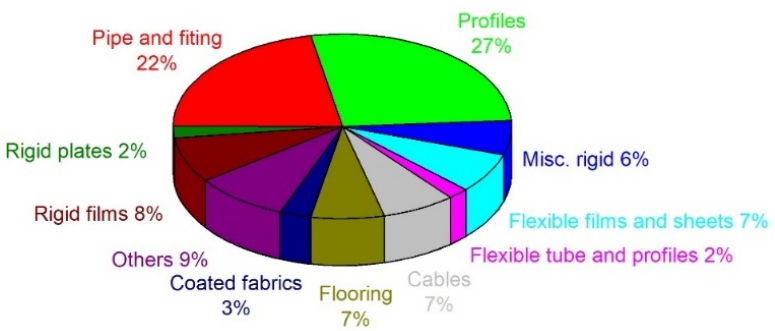
Figure 1. The use of PVC in the European Union, broken down into applications [15].